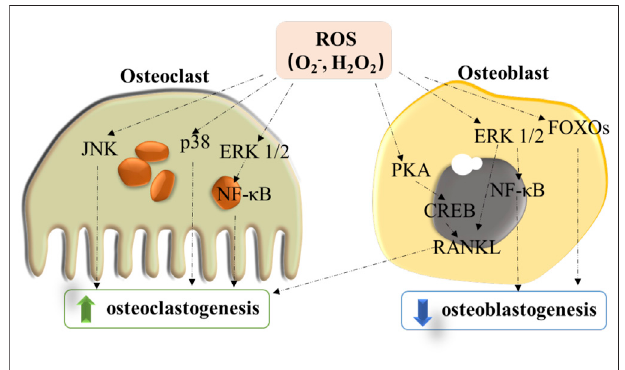
FIGURE 1 | Modulation role of ROS for signaling pathways in inhibiting osteoblast differentiation and enhancing